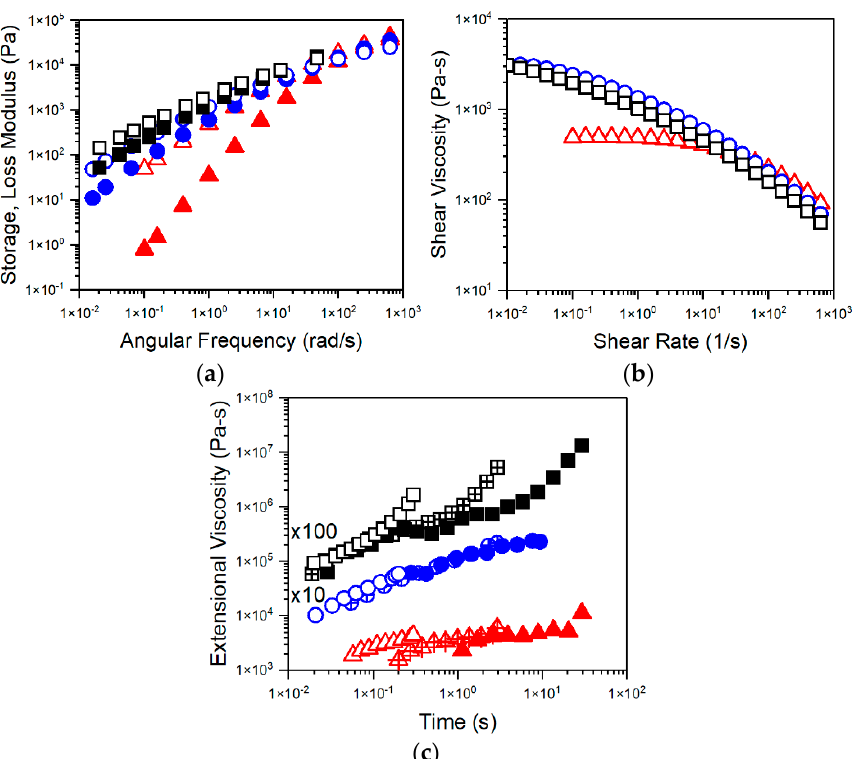
Figure 3. Rheology of Resin A (red triangles), Resin B (blue circles), and Resin C (black squares). ( a ) Storage (solid) and loss (hollow) moduli at 190 °C. ( b ) Estimated shear viscosity via Cox–Merz rule at 190 °C. ( c ) Extensional viscosity of Resin A, B (×10), and C (×100) at 175 °C using strain rates of 0.1 s − 1 (solid), 1 s − 1 (internal cross), and 10 s − 1 (hollow).